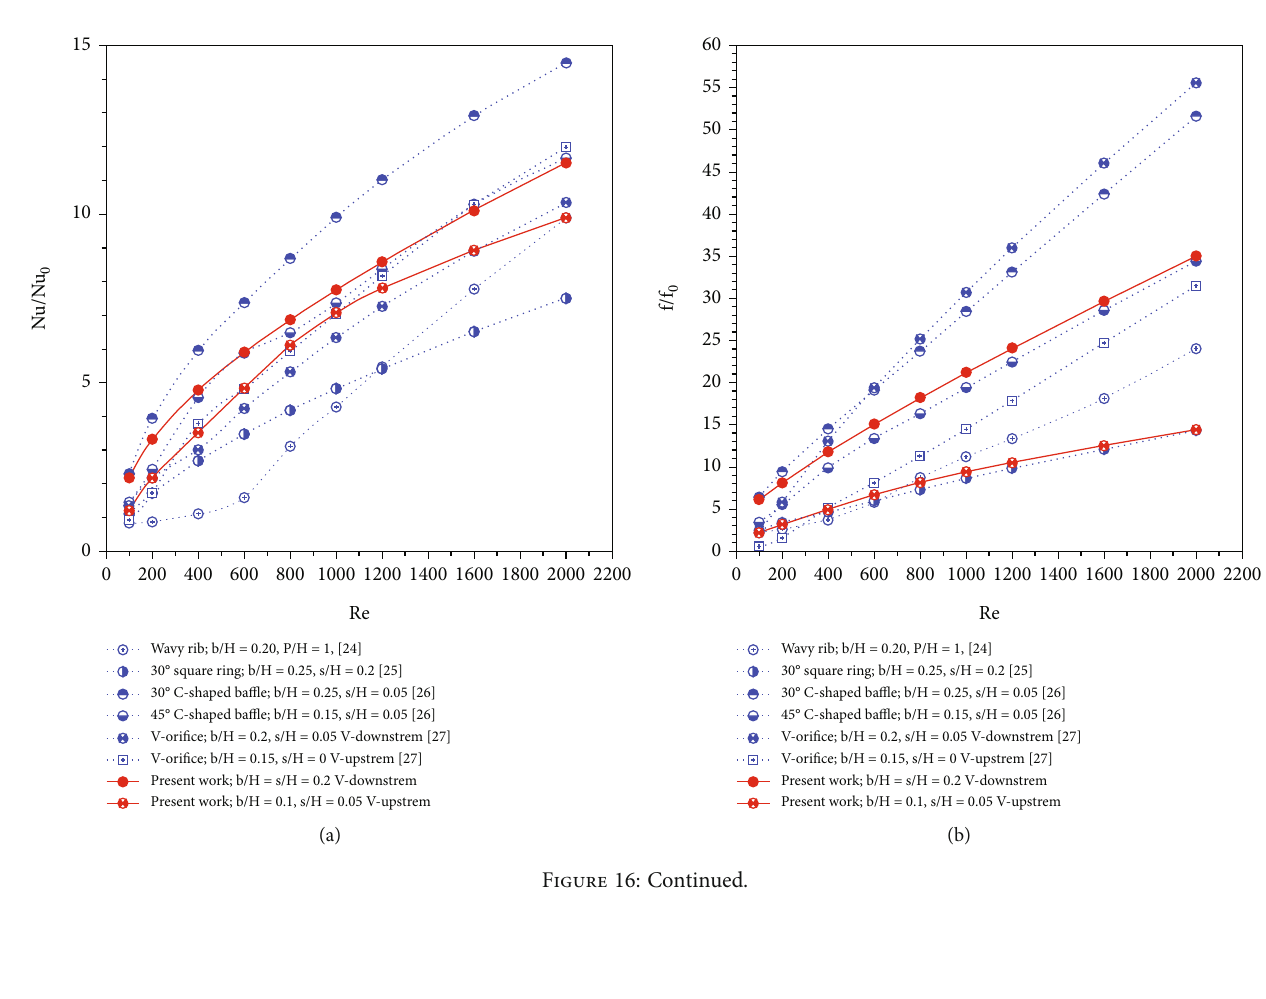
Figure 15: TEF vs. s / H for b = 0 : 10H – 0 : 20H of (a) VD and (b)